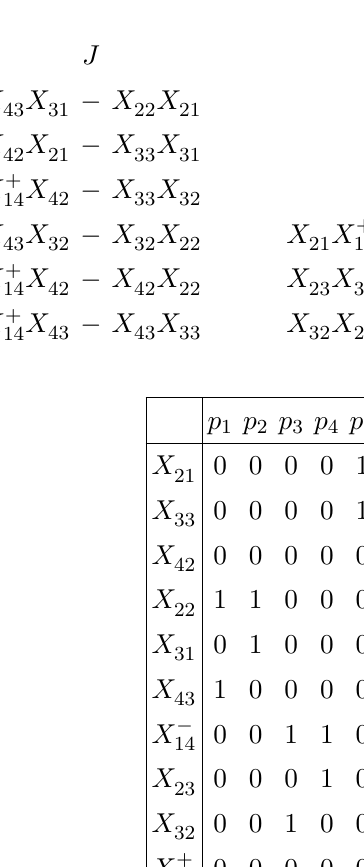
in (cid:12)gure 22. Its J - and E - terms